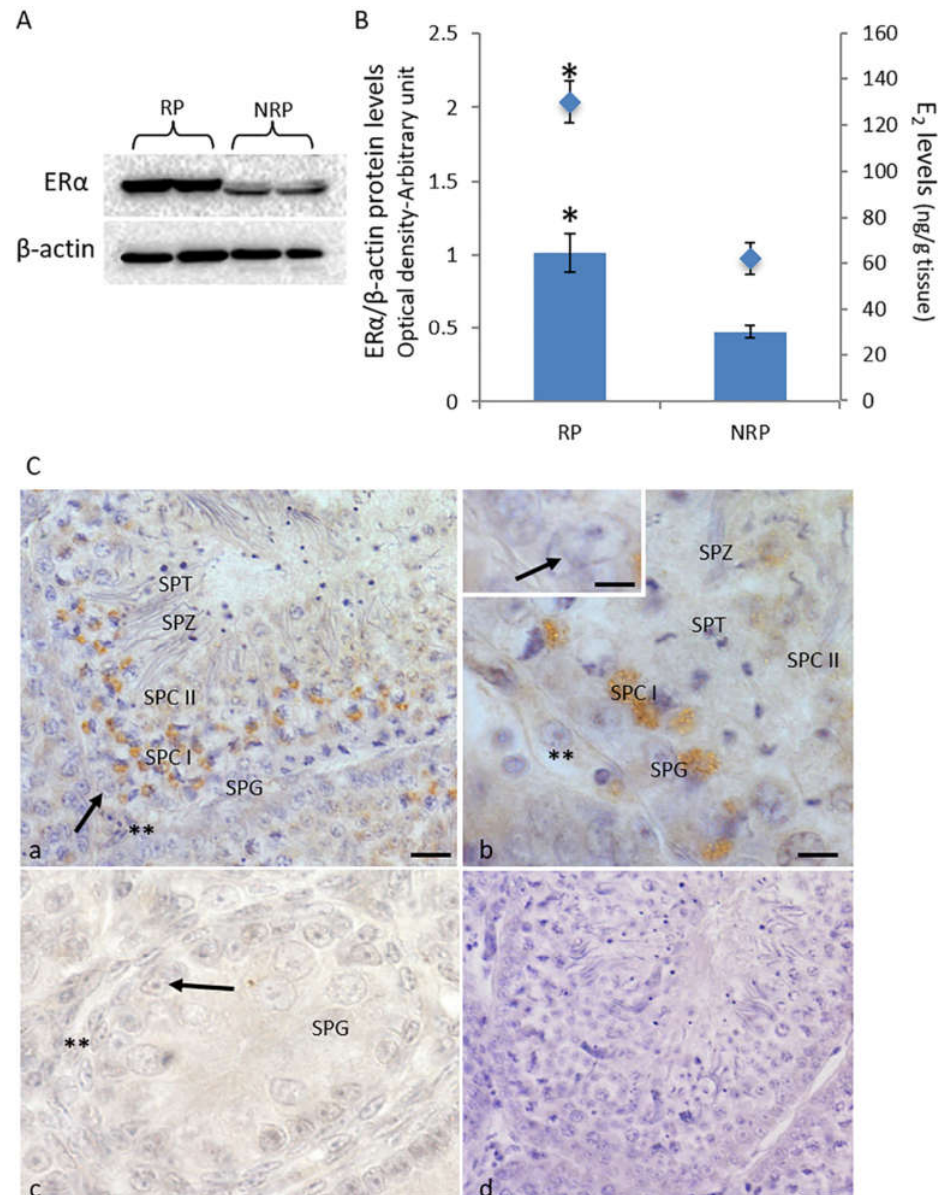
Figure 1. ( A ) Western blot detection of ER α in quail testis during reproductive and non-reproductive periods. A specific band of 66 kDa was detected. ( B ) The amount of protein was quantified using the ImageJ program and normalized with respect to β -actin protein. The values presented represent the means ± S.D. of the values obtained for five animals (two bands were shown). * p < 0.05. RP, reproductive period; NRP, non-reproductive period. ( C ) Immunohistochemical localization (brown areas) of ER α . ( a , b ) Reproductive period. The signal is evident in Leydig cells (**), spermatocytes I (Spc I) and II (Spc II), spermatids (Spt), and spermatozoa (Spz). No signal is evident in Sertoli cells (arrow) and spermatogonia (Spg). ( c ) Non-reproductive period. The signal is evident in Sertoli cells (arrow). No positivity was observed in Leydig cells (**) and spermatogonia (Spg). ( d ) Control section. Scale bars correspond to 5 µ m in ( a , c , d ) and 10 µ m in ( b